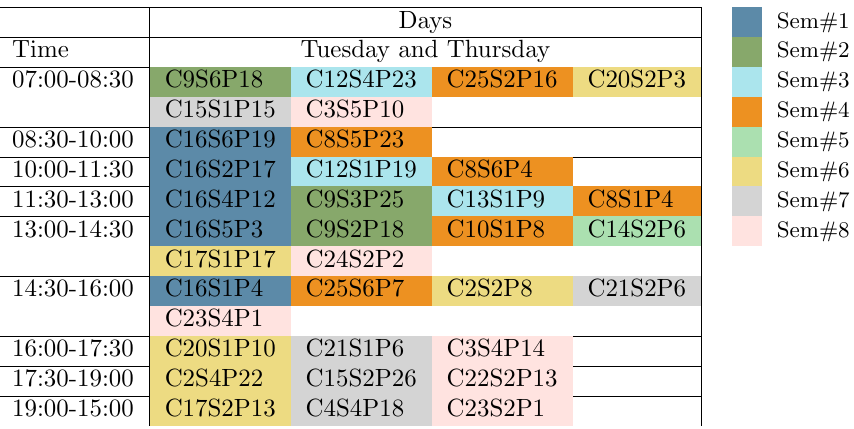
Figure 1. Timetable for courses in day scheme A: Monday, Wednesday and Friday, three classes of 1 h per week.